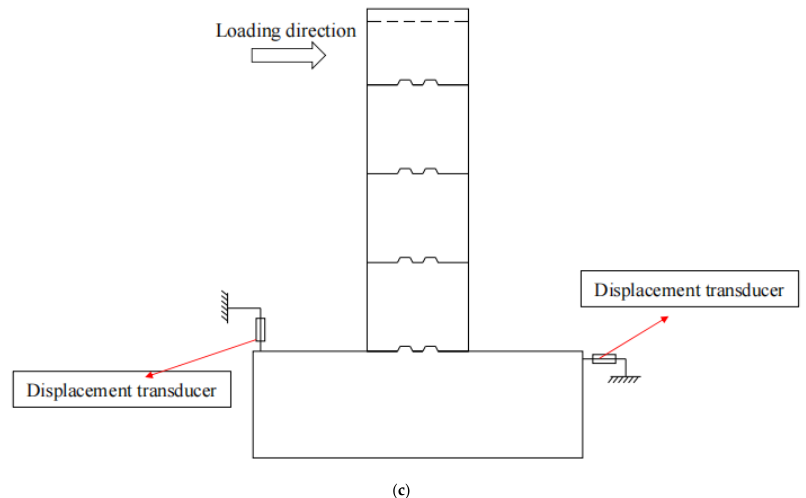
Figure 5. Instrumentation (in units of mm). ( a ) Strain gauges on concrete. ( b ) Strain gauges on reinforcing steel. ( c ) Displacement measure point. The vertical displacement sensor on the tensile side and the horizontal displacement sensor on the compressive side of the structure, with a total of 2 measurement points, were used to correct the errors caused by the movement of the bearing platform, as shown in Figure 5c.